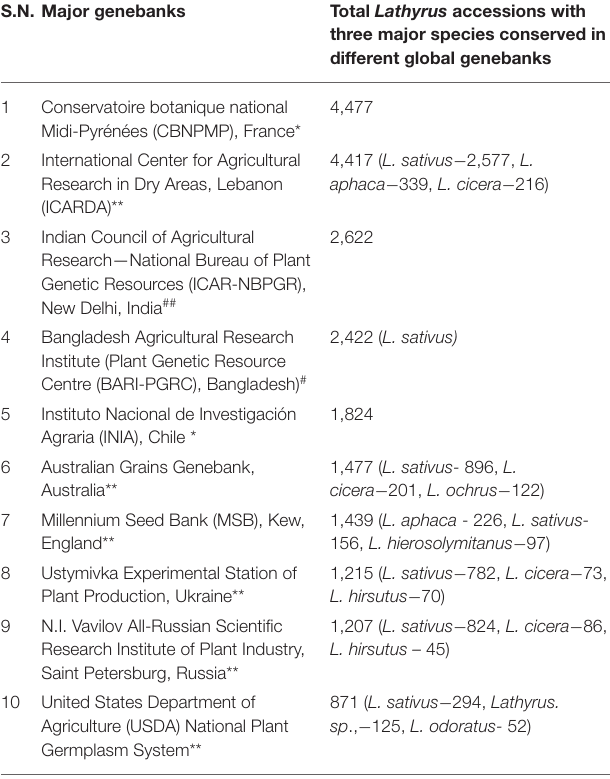
TABLE 1 | The Lathyrus holdings in major global